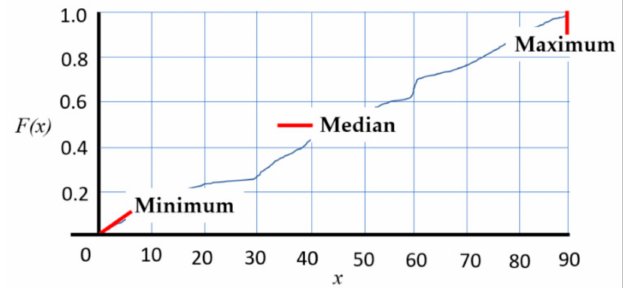
Figure 3. The CDF key